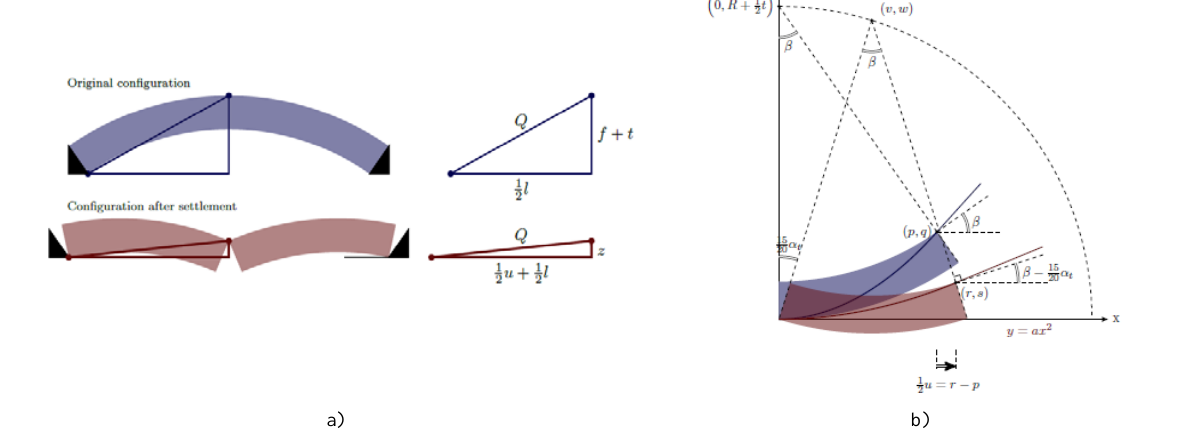
Fig. 4 Fig.s for analytical analysis of settlements; a) rigid body movement for settlement analysis region A; b) geometry definition to analyze settlement when line of thrust becomes tangent with intrados (region B). An arch in region B initially behaves the same as one in region A. Thus, the hinges will initially be located at the supports and in the middle. This means that the same rigid body movement occurs, as expressed by formula (7). After a certain settlement however, the line of thrust will be tangent to the intrados of the arch. At this point the outer hinges will start to shift to the middle, similar as to what happens in region C. Increasing the settlements further, will finally result in